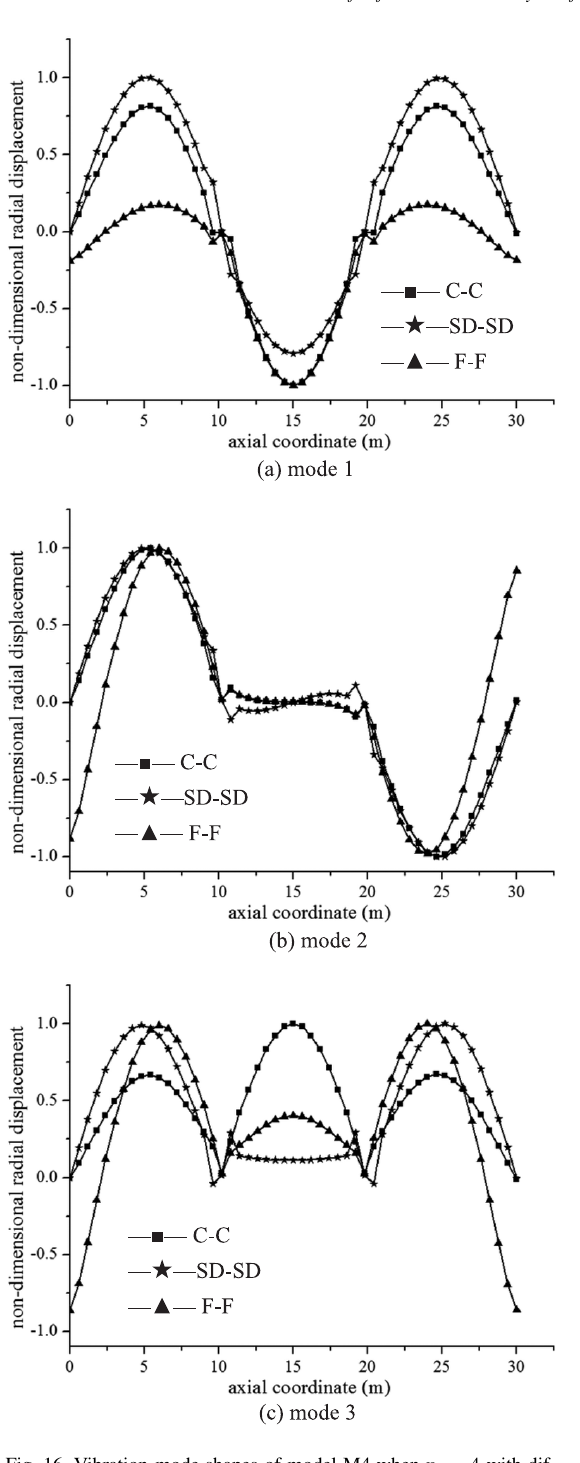
Fig. 17. Vibration mode shapes of model M5 when n = 4 with dif- ferent boundary